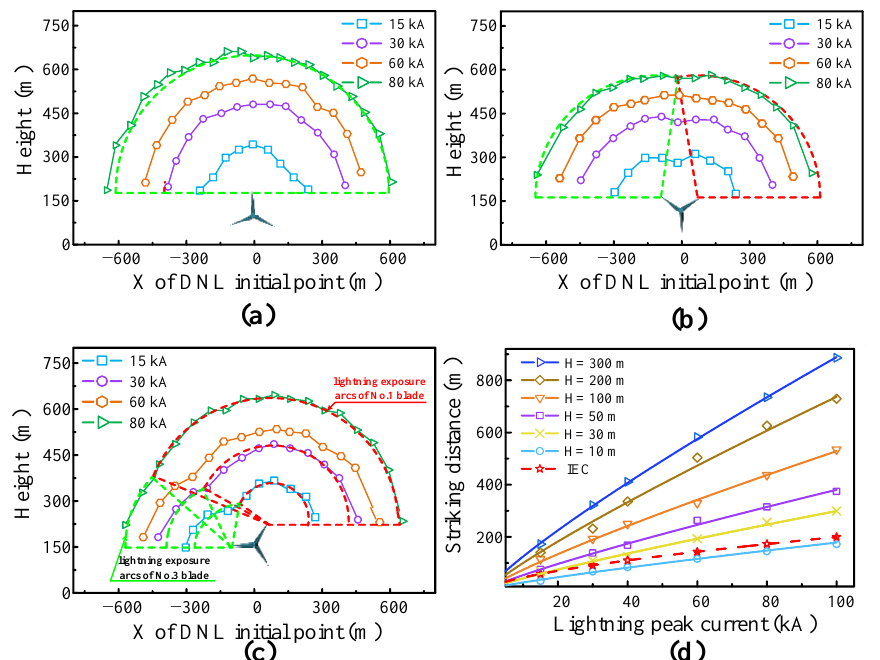
Figure 5. Simulation Results: ( a ) Lightning exposure arc of the wind turbine blade when 𝜃 = 0 ° , ( b ) 𝜃 = 60 ° , ( c ) 𝜃 = 30 ° , ( d ) The relationship among the striking distance, the wind turbine height and the lightning current amplitude.